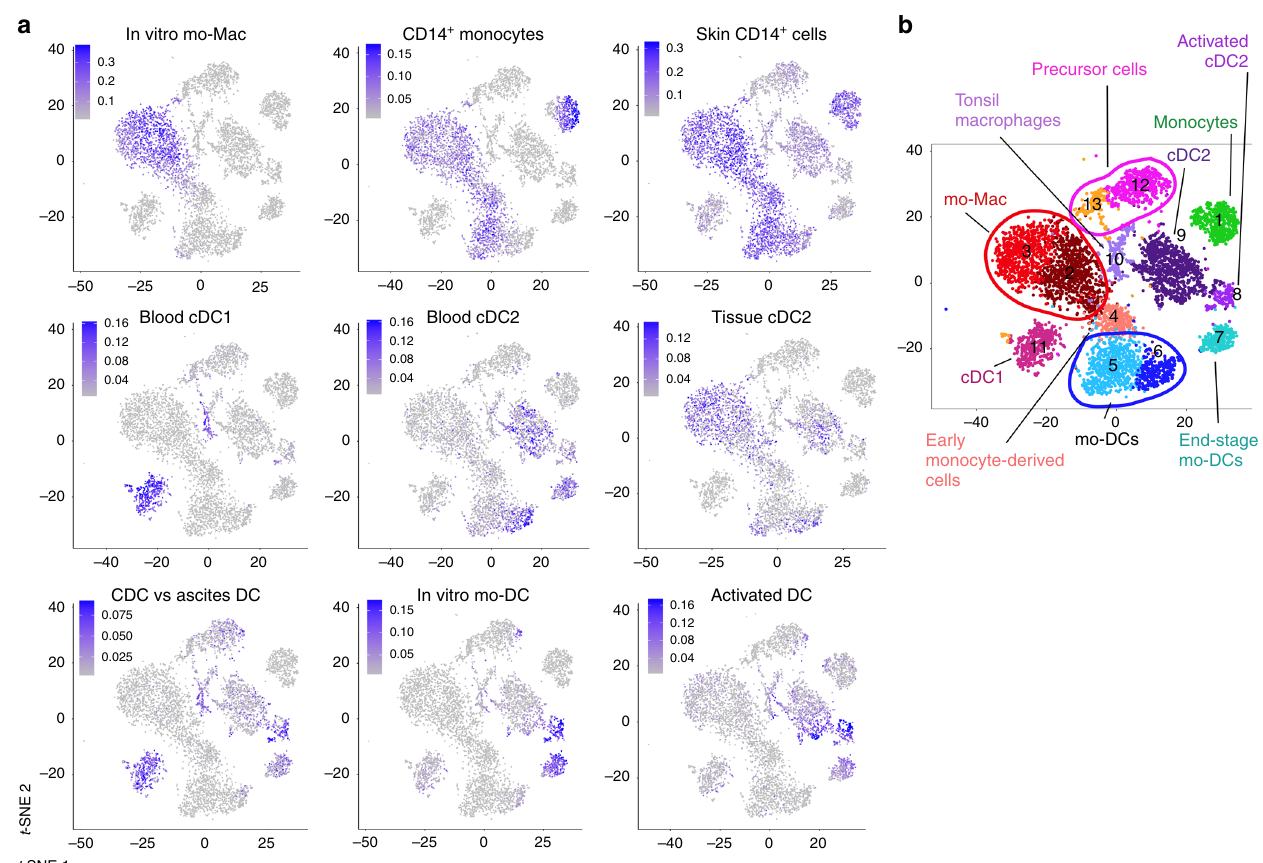
Fig. 2 Ascites DCs are monocyte-derived cells. Puri fi ed ascites DCs, ascites macrophages, tonsil DCs, and blood monocytes were analyzed by single-cell RNA-seq using a Drop-seq approach. Combined single-cell transcriptomes were analyzed. a Signature scores in individual cells for indicated gene signatures. b Annotation of cell